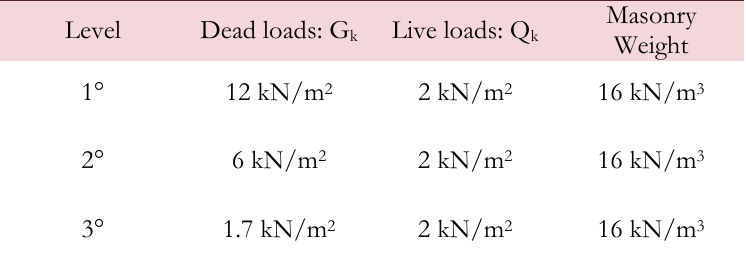
Table 2: Values of loads and masonry parameters.